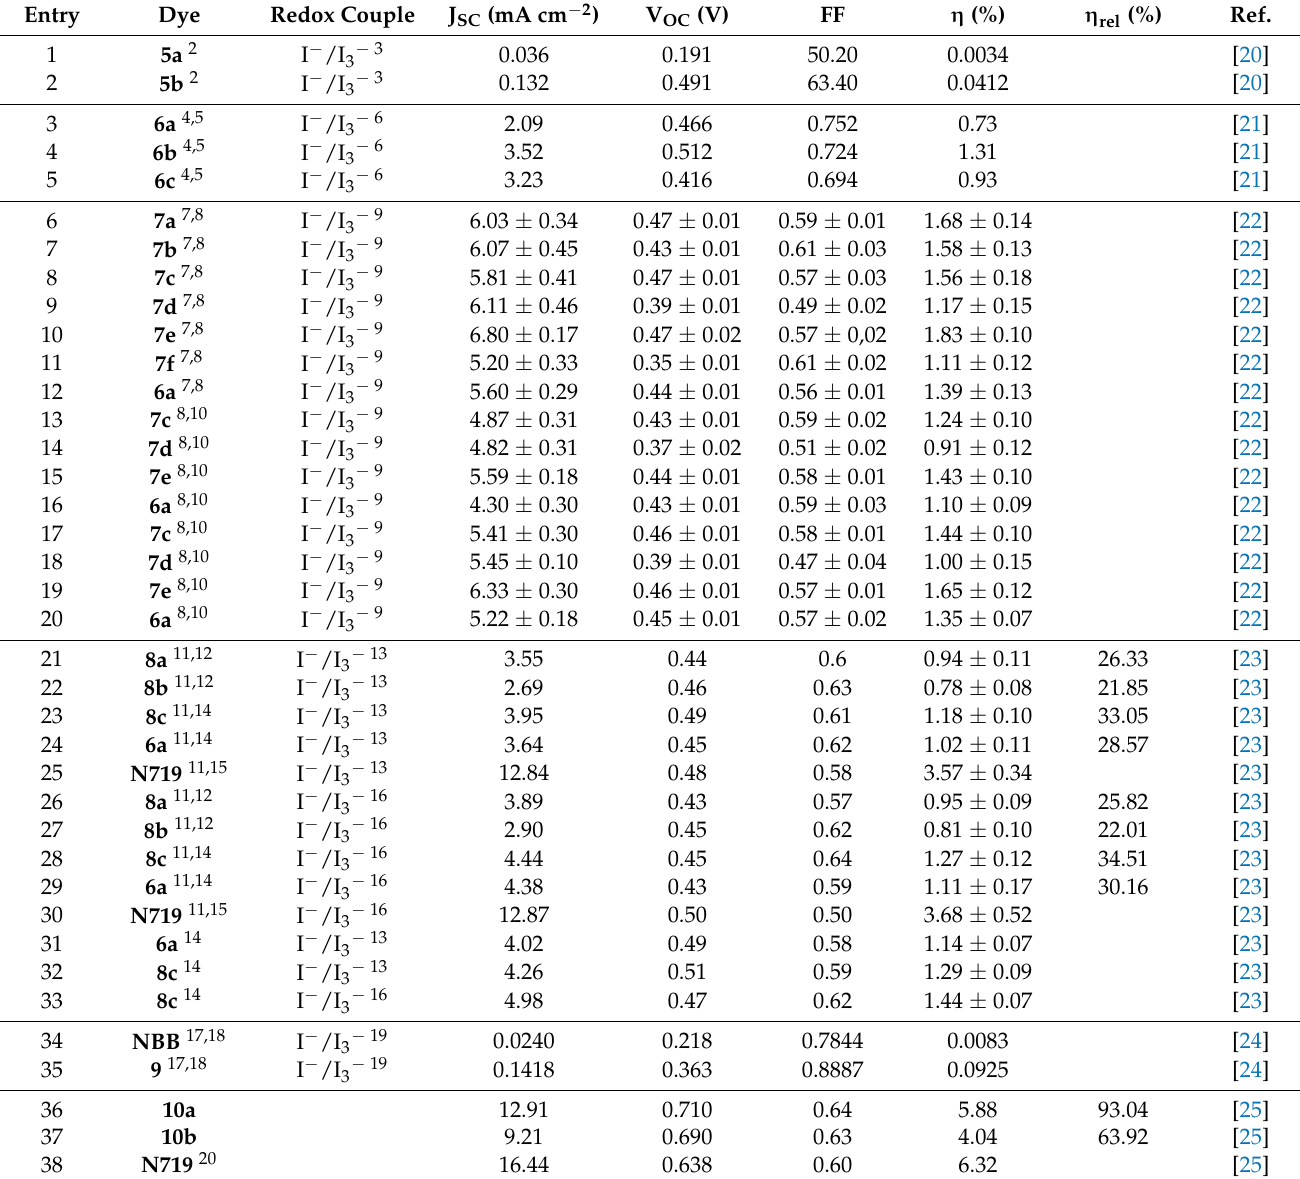
1 using FTO as conductive oxide, TiO 2 as semiconductor, Pt as counter-electrode, and under AM 1.5G-simulated light source (100 mW cm − 2 ) if not differently specified. 2 0.02 M + 0.002 M chenodeoxycholic acid (CDCA) in ACN. 3 Solaronix Iodolyte AN-50. 4 Nippon sheet glass; 8 Ω sheet resistance. 5 0.2 mM dye in can; then 0.5 mM CDCA in ACN. 6 0.1 M LiI + 0.05 M I 2 + 0.6 M 1,2-dimethyl-3-propylimidazolium iodide (DMPII) in 3-methoxypropionitrile (MPN). 7 DSSC fabricated with a 20 µ m TiO 2 layer. 8 PEDOT counter electrode. 9 0.1 M LiI + 0.6 M 1-methyl-3-propylimidazolium iodide (PMII) + 0.1 M I 2 + 0.1 M MgI 2 + 0.1 M guanidinium thio- cyanate (GuNCS) + 0.1 M TBAI in ACN. 10 DSSC fabricated with a 16 µ m TiO 2 layer. 11 PEDOT counter electrode. 12 0.05 M in ACN. 13 0.1 M LiI + 0.6 M PMII + 0.1 M I 2 + 0.1 M MgI 2 + 0.1 M GuNCS in ACN.